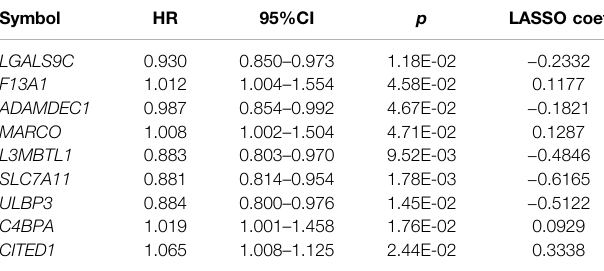
TABLE 2 | Optimal combination immune-related DEGs.